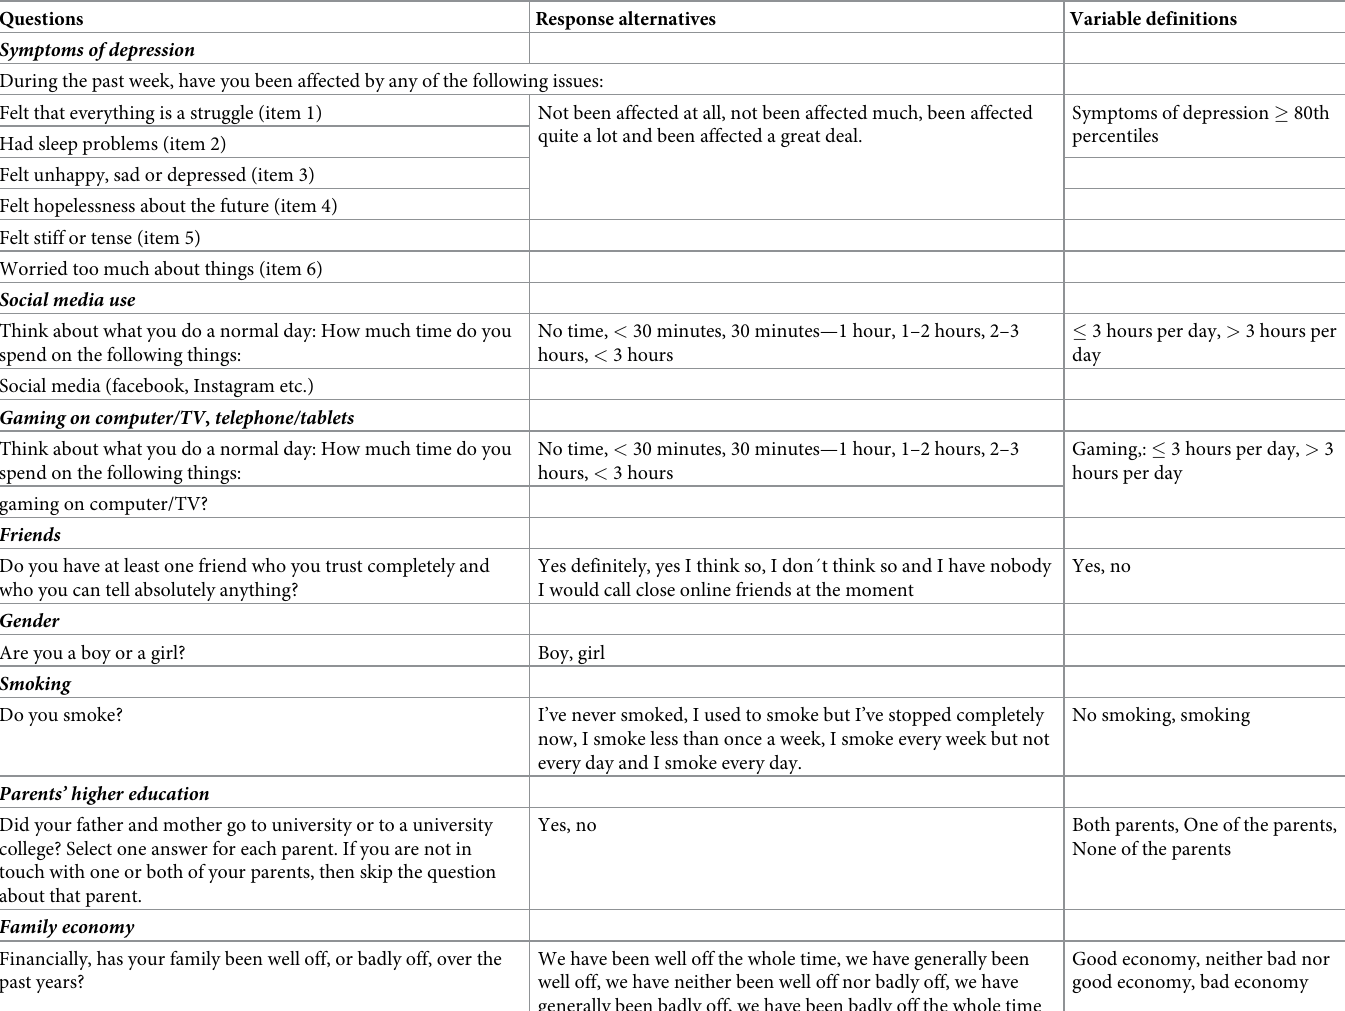
Table 1. Ungdata Survey 2018: Questions, response alternatives and variable definitions.